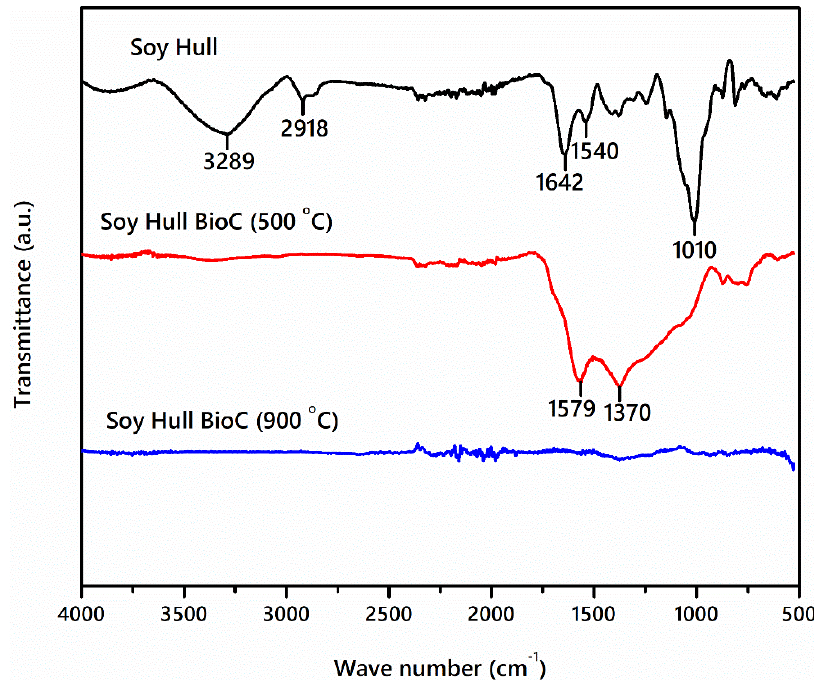
Figure 3. FTIR spectra of soy hull biomass, 500 °C soy hull biocarbon and 900 °C soy hull biocarbon. Wavenumbers of characteristic peaks are shown on the graph with units of cm − 1 .